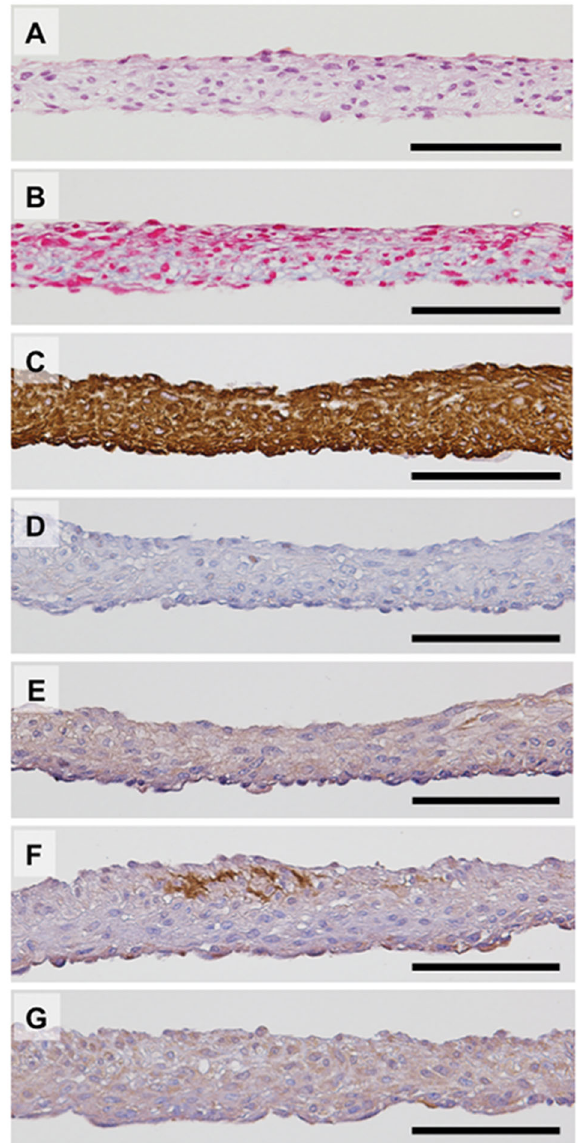
Fig. 2 Characterization of autologous dermal fi broblast sheet. Autologous dermal fi broblast sheets (DFSs) can be harvested by low-temperature treatment and are harvested as intact sheets. Hematoxylin and eosin ( A ) and Azan ( B ) staining show that DFSs are composed of two to seven cell layers. Azan staining also showed extracellular matrix present within the harvested DFSs. Immunohis- tological analysis is shown for expression of vimentin ( C ), alpha- smooth muscle actin ( D ), collagen type 1 ( E ), collagen type 3 ( F ), and fi broblast growth factor 2 ( G ). Scale bars indicate 100 μ